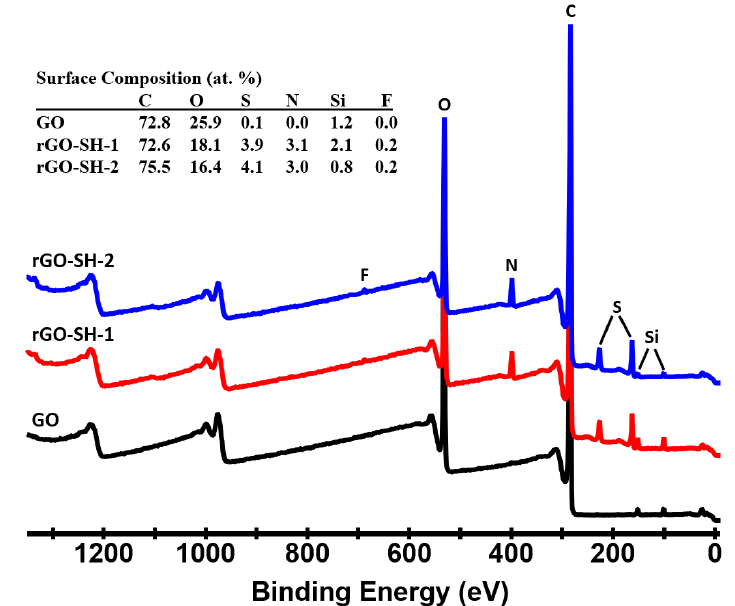
Figure 1. XPS survey scans and the overall surface composition of the graphene oxide (GO) and reduced graphene oxide functionalized with cysteamine (rGO–SH). Two functionalized rGO–SH samples were measured. They are designated on the plot as rGO–SH-1 and rGO–SH-2. The peaks at approximately 980 and 1200 eV are the oxygen and carbon O–KLL and C–KLL Auger peaks, respectively.